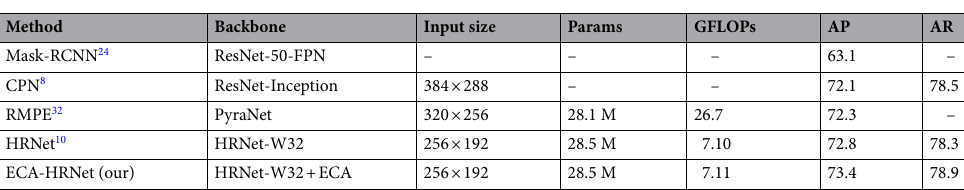
Table 4. Comparisons on the COCO test-dev set. #Params and FLOPs are calculated for the pose estimation network, and those for human detection are not included.